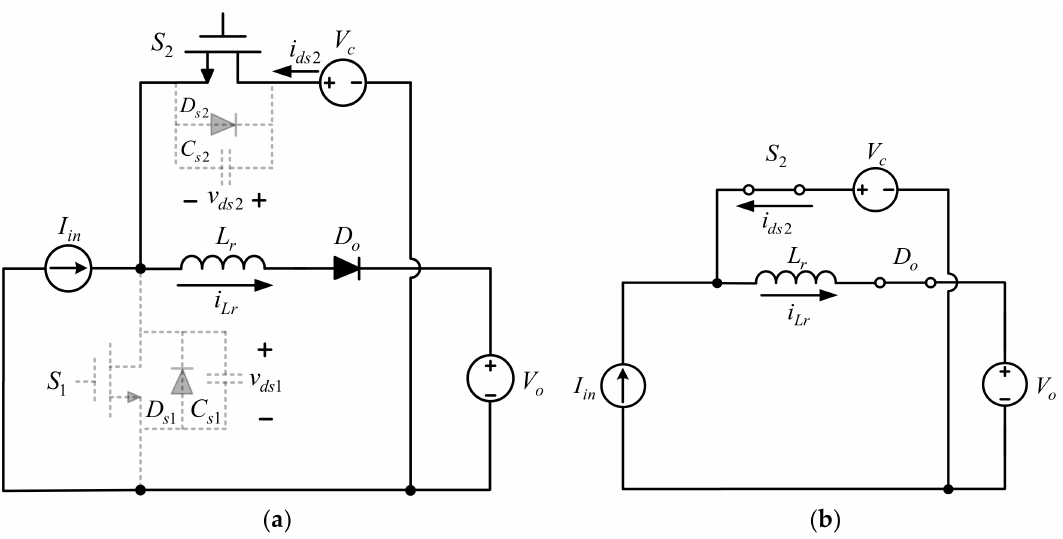
Figure 8. ( a ) Current path for stage 5; ( b ) equivalent of ( a